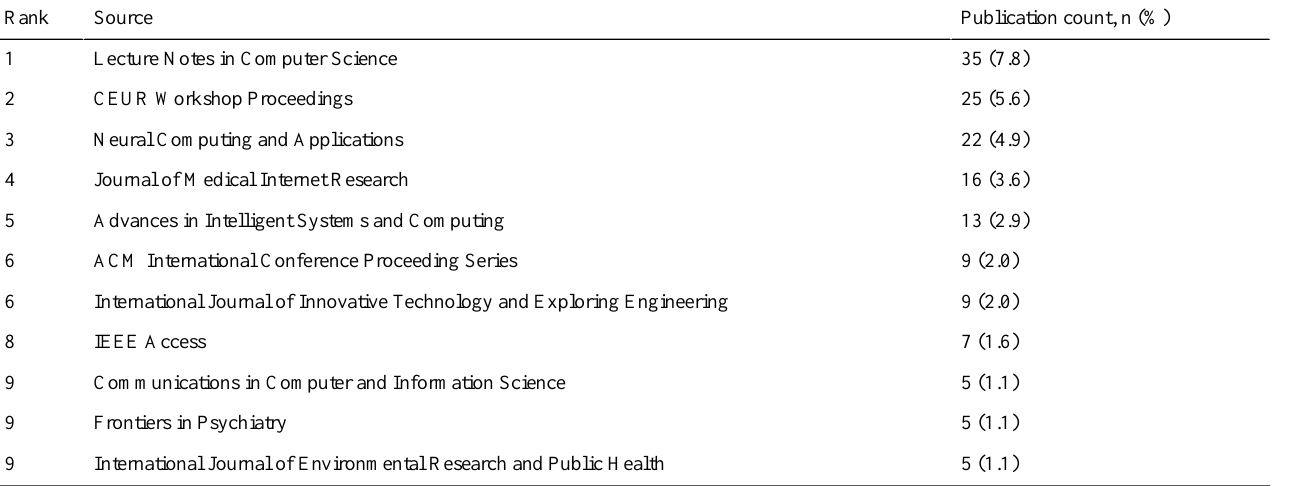
Table 2. Top publication sources in Scopus